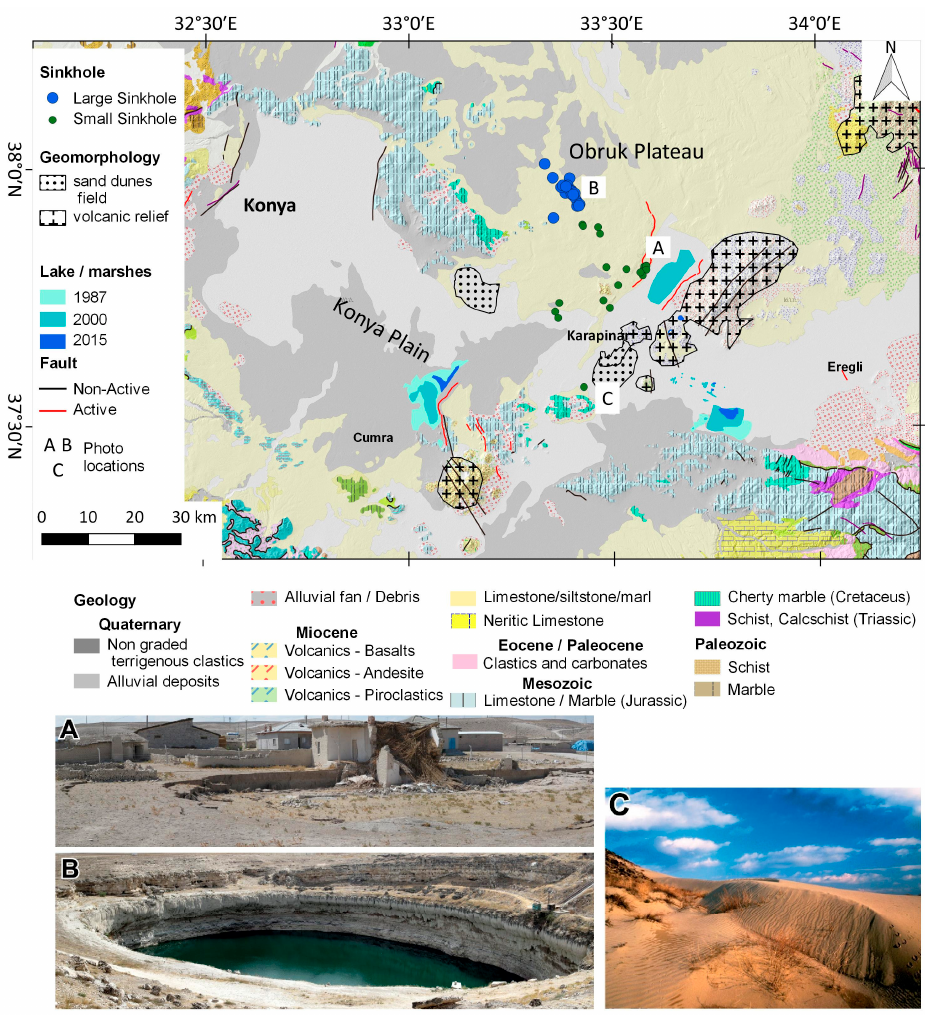
Figure 2. Geological and geomorphological map of the study area (adapted from [37]). Dynamic Figure 2.